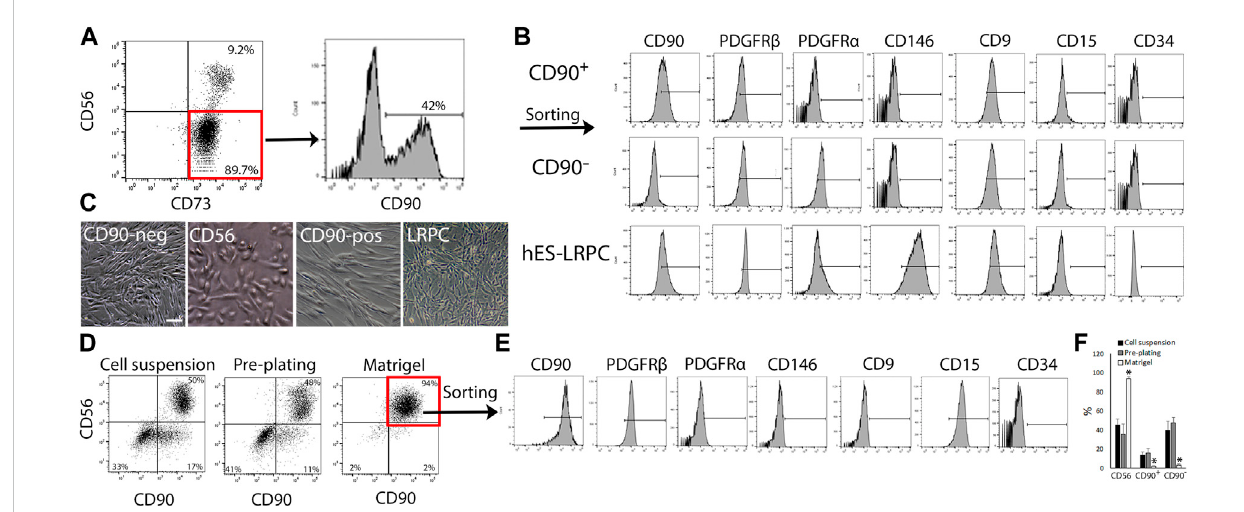
FIGURE 2 Identi fi cation and isolation of primary cell subsets from human muscles. (A) Representative fl ow cytometry analyses of CD73, CD56 and CD90 expression by primary human muscle cells cultured in EGM-2 medium at passage 0 (n = 8 donors). (B) Representative fl ow cytometry analysis of expression of characteristic cell surface markers: CD90, PDGFR- β , and CD146 (perivascular cells); CD9 (adipogenic progenitors), CD15 (myoblasts) and CD34 (endothelial, hematopoietic progenitors and adventitial cells) by either expanded human muscle cell sorted subsets (CD90 + and CD90 − ) or lineage restricted, perivascular-like cells (LRPC) that were derived from hES.Cells wereanalyzed between passages 1 and 5. (C) Representative images of cultured human muscle subsets and hES-LRPC. (D) Representative dot plots of tested conditions for human muscle myoblast enrichment and sorting strategy of myoblasts based on the expression of CD56 and CD90. Nearly all muscle cells were myoblasts when expanded in Matrigel coated dishes and EGM-2mediumatpassage0(rightpanel). (E) Flowcytometryanalysisofco-expressionofperivascularmarkers,CD90,PDGFR β andCD146aswellasthe myoblast marker CD15 by sorted CD56 + CD90 + human muscle-derived myoblasts between passages 1 – 3. (F) Frequency of CD56 + , CD90 + and CD90 − subsets, harvested from uncoated culture dishes (cell suspension and pre-plating) or Matrigel coated dishes between passages 0 and 1. Data are mean ± SD, n = at least 3 donors per cell subset. Data analyzed via one-way ANOVA. * p < 0.001 between frequency of cell subset that was cultured on Matrigel, and the matched cell subset in cell suspension and pre-plating culture conditions. Scale bar represents 100 μ